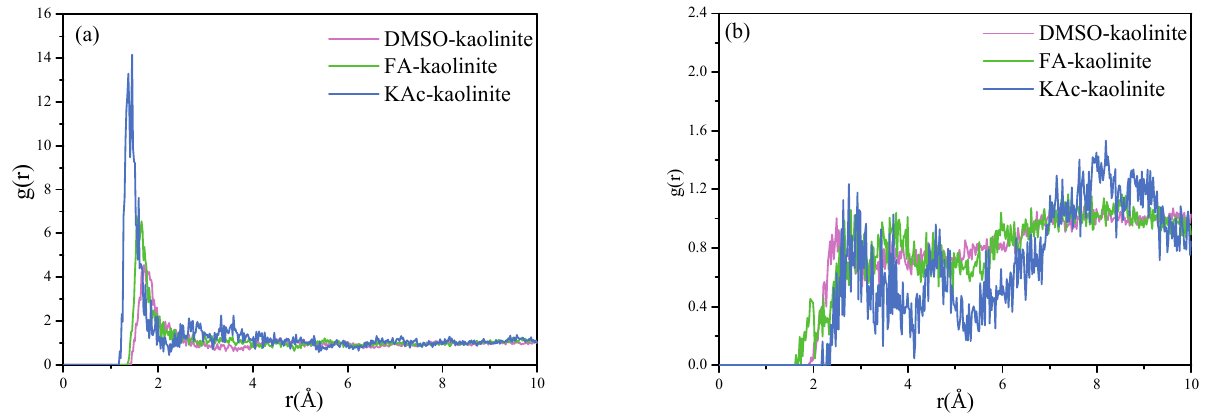
Figure 8. ( a ) RDF calculated for hydroxyl hydrogen atoms of the alumina octahedral surface of kaolinite to oxygen atoms of KAc, FA and DMSO and ( b ) RDF calculated for oxygen atoms of silicon tetrahedral surface of kaolinite to hydrogen atoms of KAc, FA and DMSO.